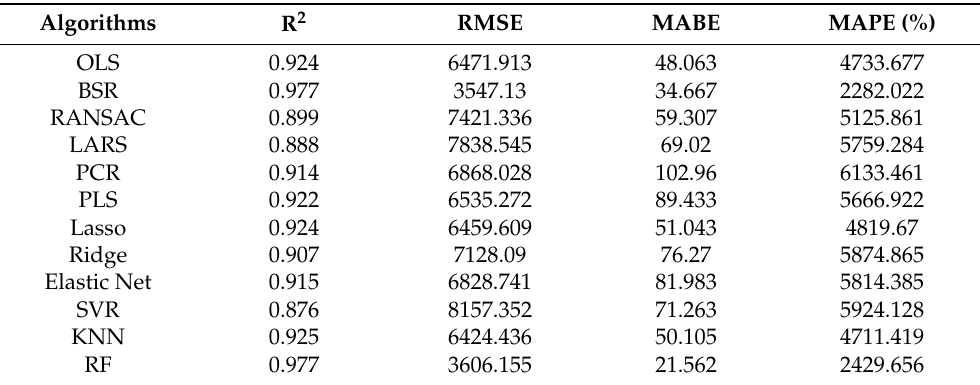
Table 7. Evaluation of decomposition